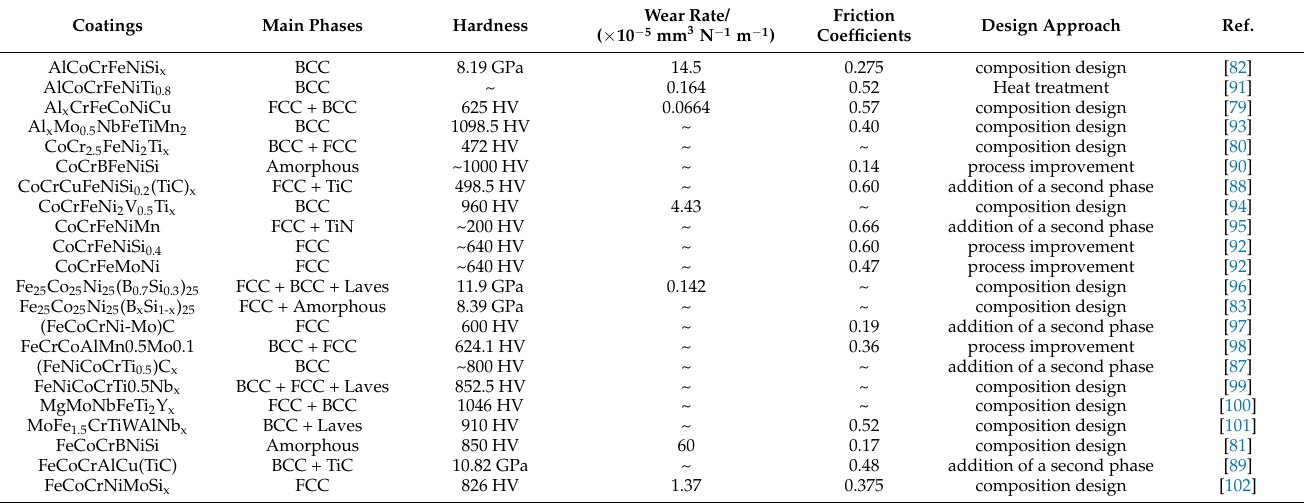
Table 2. The microstructure and tribological properties of HEA coatings prepared by laser cladding.